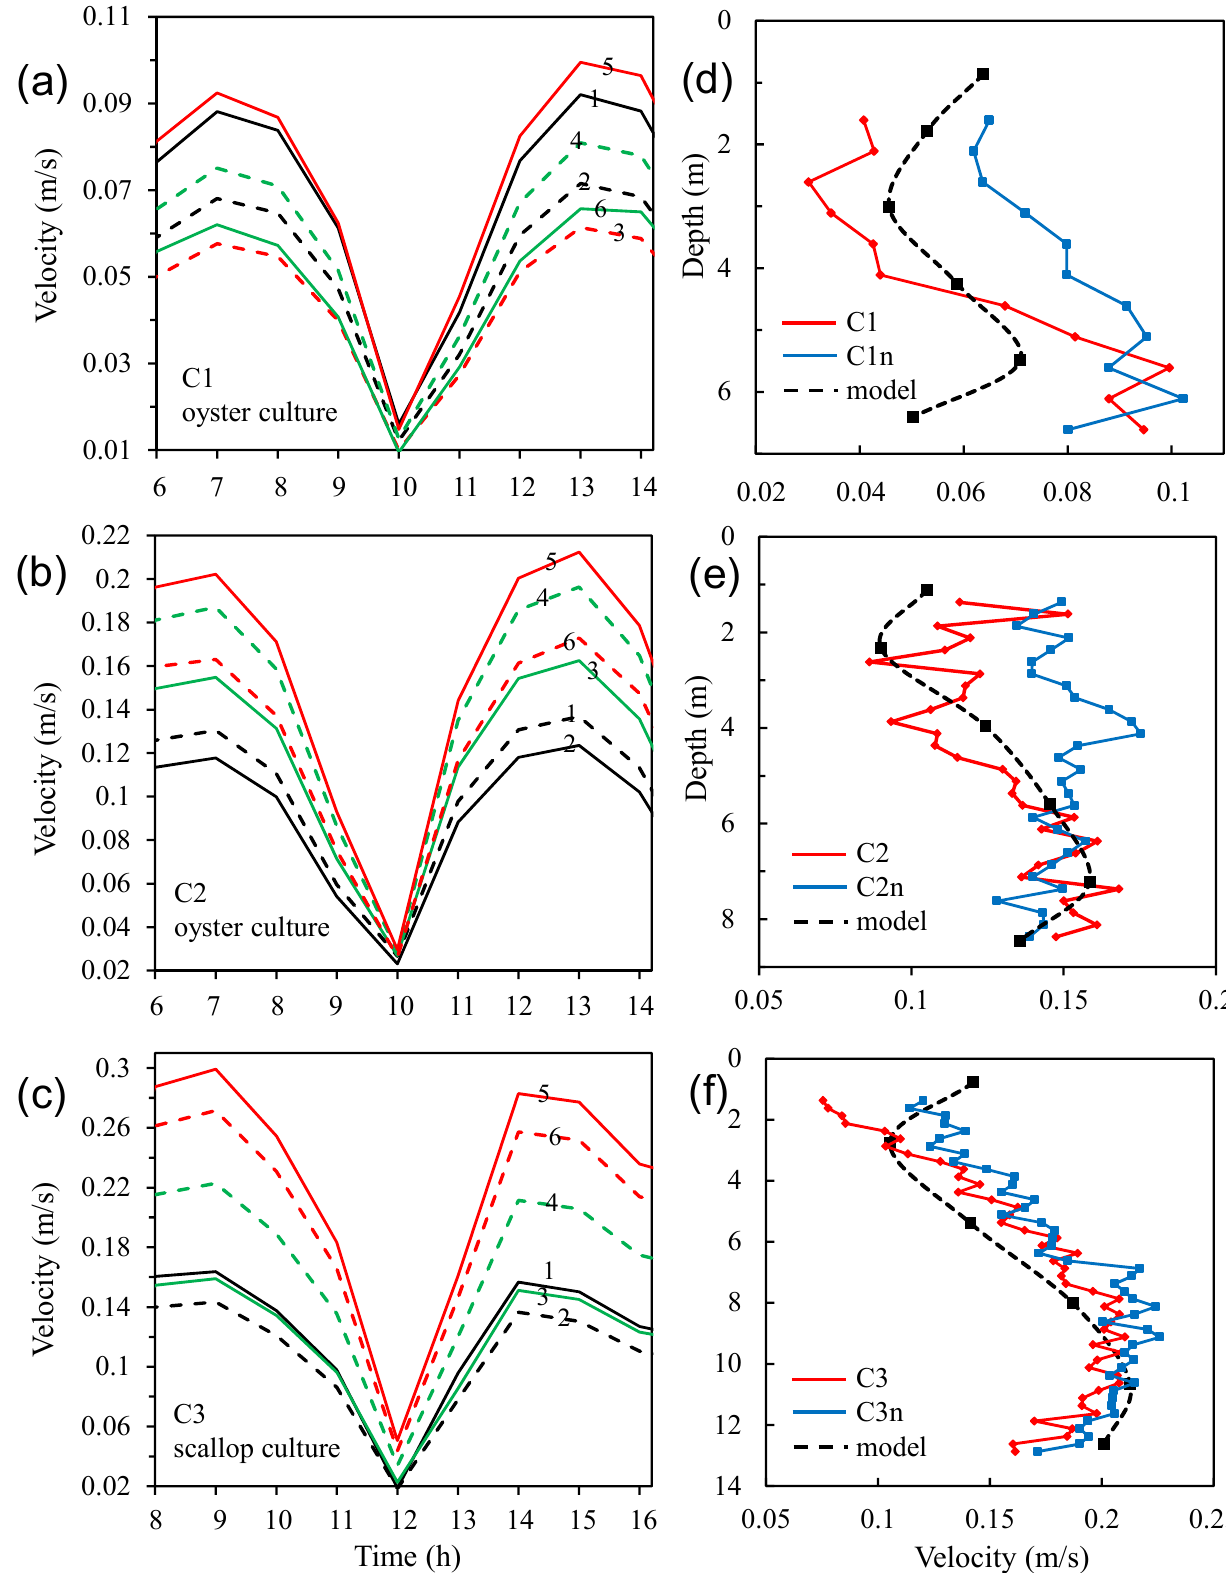
Figure 7. Vertical profiles of current velocities in aquaculture zones of Sungo Bay in the presence of bivalve cultures: simulated time series at six layers at ( a ) C1, ( b ) C2, and ( c ) C3 (1–6 represent the 1st–6th model layer); comparison of observed and simulated velocities (averaged within observation periods) for ( d ) C1, ( e ) C2, and ( f )